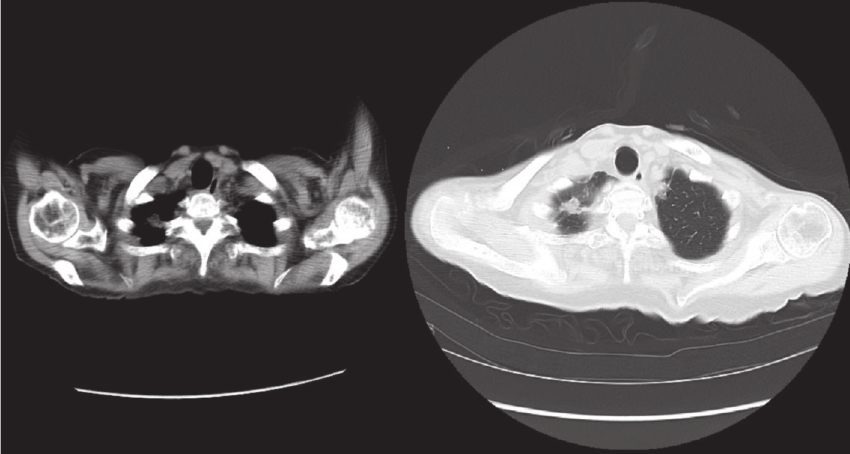
Figure 1: Chest CT showing thickening of the pleura and a nodule at the apex of the left